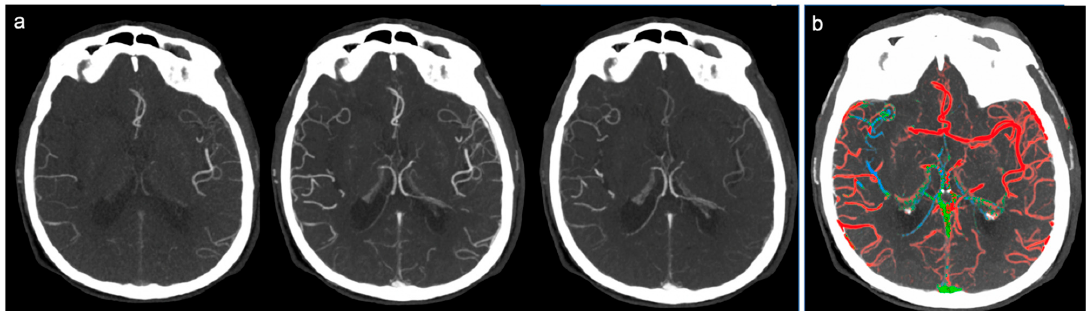
Figure 1. Example of good collateral circulation at ColorViz. ( a ) mCTA shows a right-sided M1 segment occlusion with good pial artery filling (1 phase delay); ( b ) ColorViz map shows predominant red vessels in the a ff ected territory downstream from the occlusion (score of 3).